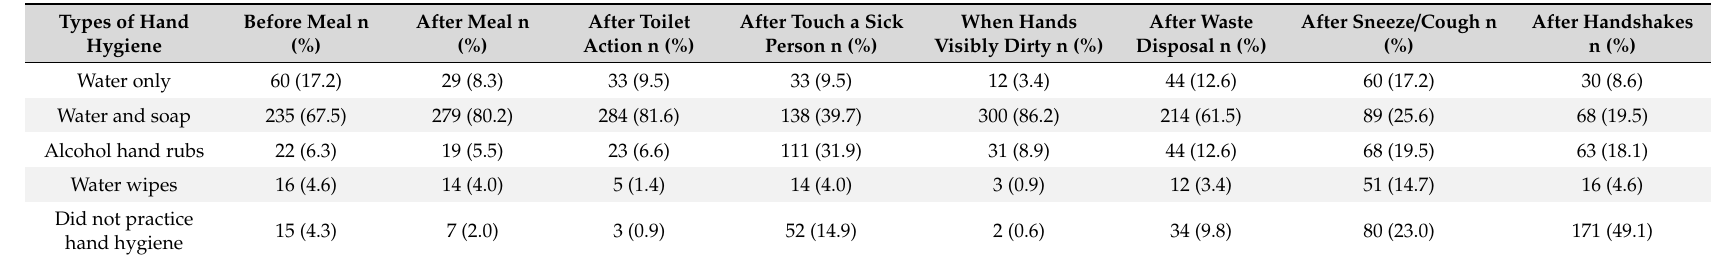
Table 4. Respondents’ hand hygiene practices and methods used in different situations during Hajj (N =